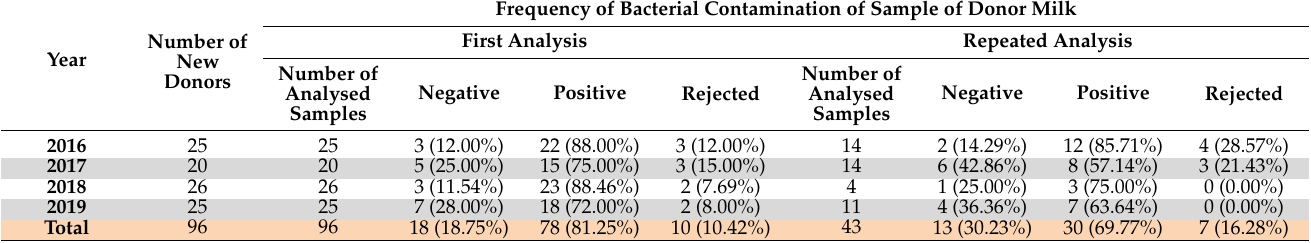
Table 2. Number of new donors’ milk samples per year and distribution of the results of microbiolog- ical analysis of the raw milk